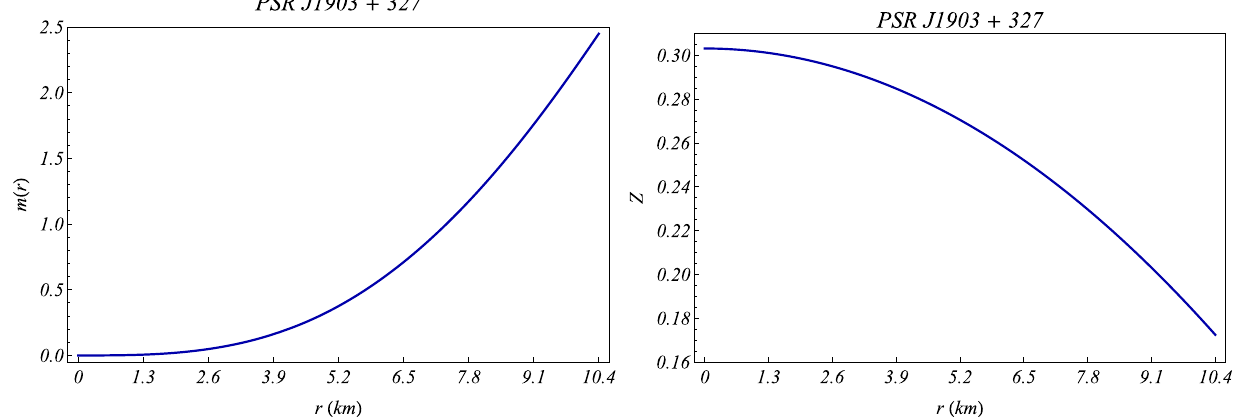
Fig. 5 (Left) The mass function and (right) the gravitational redshift are plotted against r inside the stellar interior for the compact star PSR J1903+327 C D = )(cid:16)( r ) 16 b 3 / 2 ( a + br 2 b b (cid:16) √ (cid:7) × − 2 a 2 + 3 abr 2 b + 2 b ( − 8 + br 4 b ) b ((cid:16)( r b )) 2